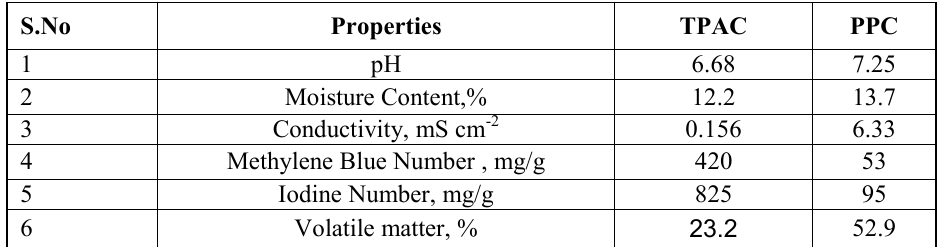
Table 1. Physico – Chemical characteristics of TPAC and PPC.